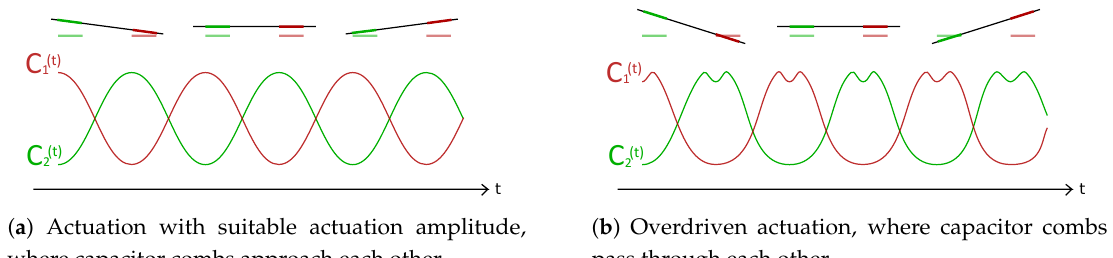
Figure 4. Schematic representation of the actuation limit for a capacitive readout. The channel section with comb structures floats slightly above the fixed comb structures when stationary due to residual stress in the channel. Large actuation amplitude ( b ) gives nonlinearity in the capacitance signals, limiting the signal-to-noise